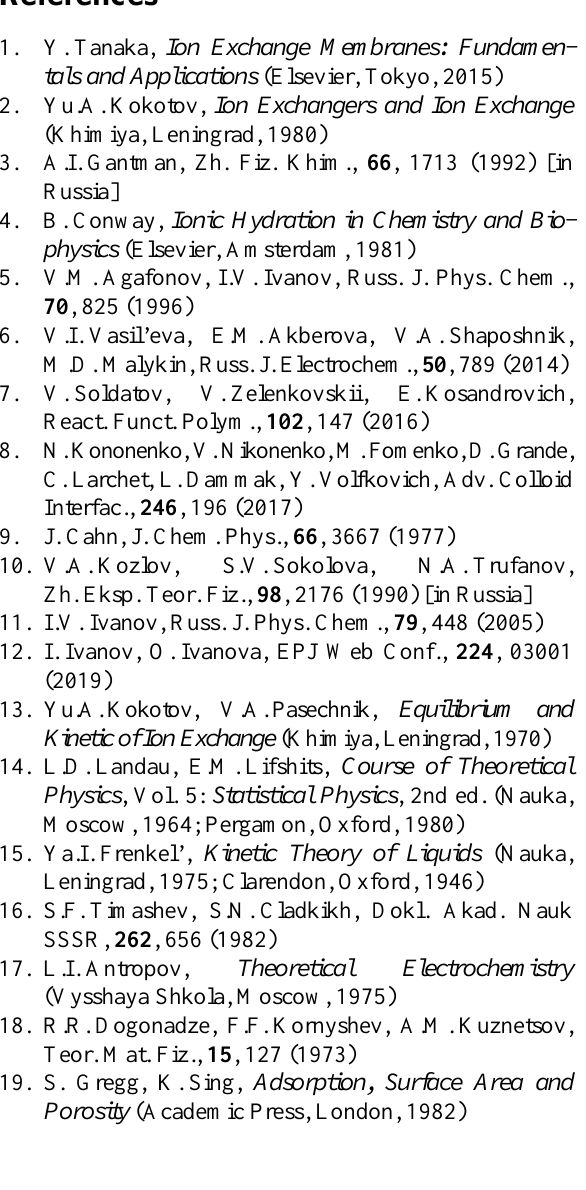
β 0 = 2, C = 10,27 ( 3